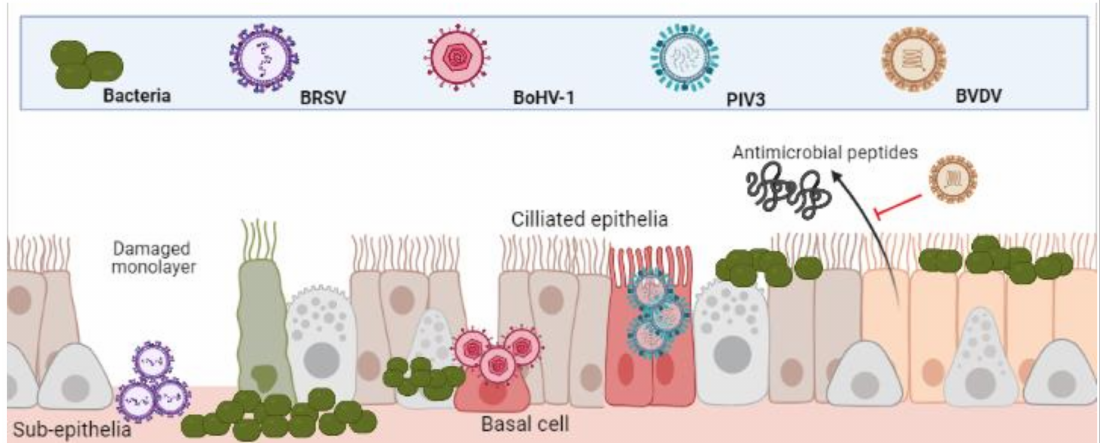
Figure 1. Differential infection of upper and lower respiratory epithelia and subsequent bacterial colonisation. Viral infection leads to inhibition of function and cell death. This both increases bacterial adherence to, and colonisation, of the lower respiratory tracts. (Created in BioRender.com, accessed on 24 March